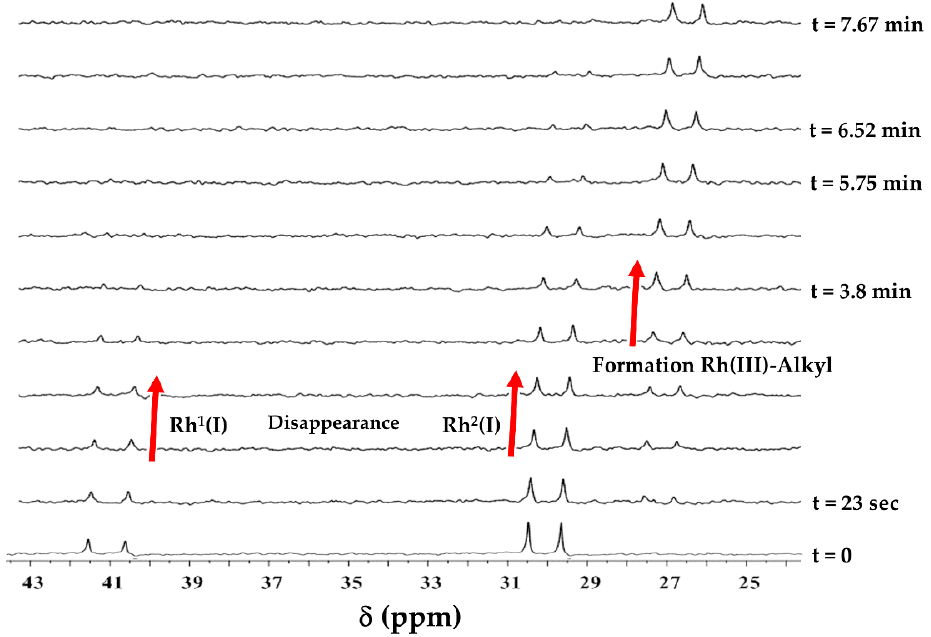
Figure 5. Observed 31 P{ 1 H} NMR spectra illustrating the oxidative addition of iodomethane to [Rh 1 (Indol’)(CO)(PPh 3 )Rh 2 (CO)(PPh 3 ) 2 ] ( B2 ) in dichloromethane at 25 ◦ C. Spectra show the dis- appearance of the Rh 1 (I) and Rh 2 (I) sites and the formation of the Rh III -alkyl (progress as per red arrows). Total peak integrals were obtained against time for 98 spectra. However, only selected spectra are plotted here to illustrate the decrease/increase in peaks (the number of scans = 12), k obs = (5.6 ± 0.2) × 10 − 3 s − 1 for Rh 1 (I)/Rh 2 (I), and (5.62 ± 0.17) × 10 − 3 s − 1 for Rh III -alkyl. The spectra were referenced externally to 85% H 3 PO 4 ( δ = 0 ppm). [ B2 ] = 0.0058 M; [MeI] = 0.064